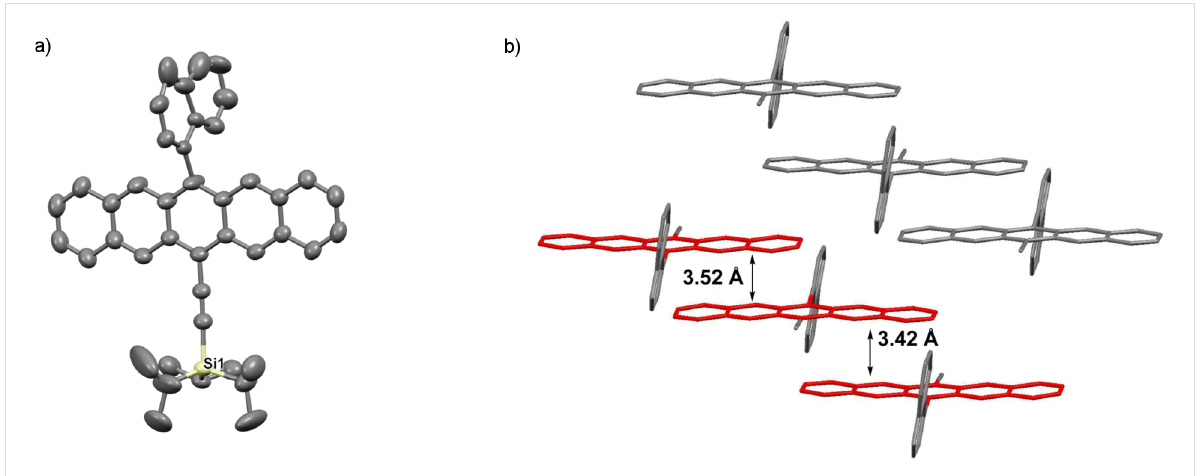
Figure 6: X-ray crystallographic analysis of 3b showing a) molecular structure and b) packing motif (triisopropylsilyl groups omitted for clarity); ORTEP drawn at 50% probability level.